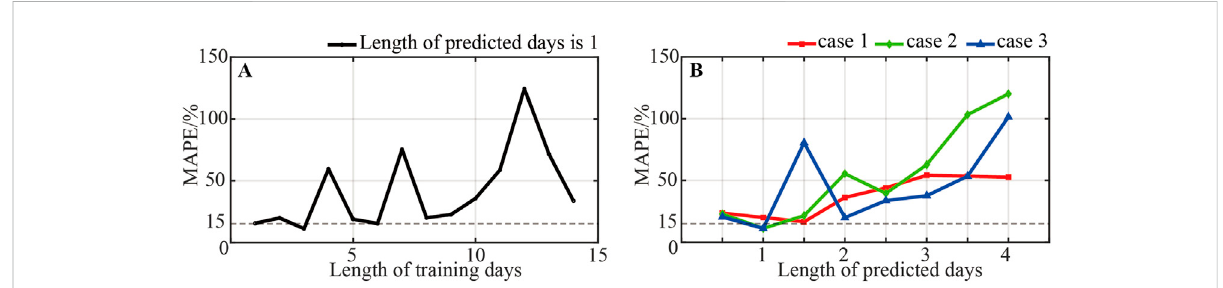
FIGURE 10 Exploring the optimal length of training and predicting. (A) shows the curve of MAPE between predicted and measured values as a function of traininglength; (B)